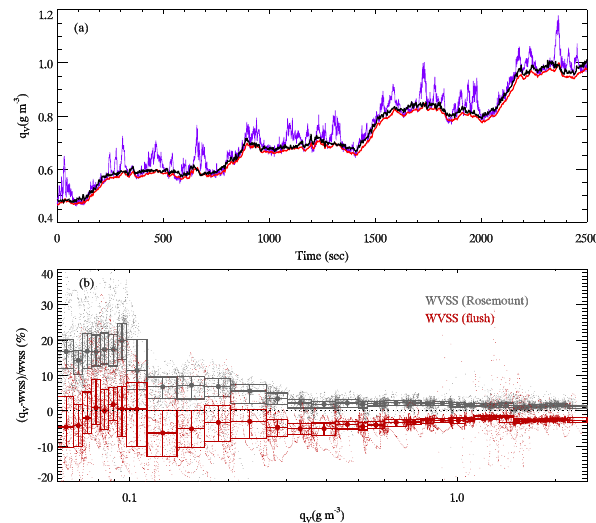
Figure 7. Time series from flight B672 showing part of a La- grangian, “race-track” pattern descent through cirrus cloud with embedded fall streaks. Upper panel shows absolute humidity from wvssF (black), wvssR (red) and TWC (purple). Lower panel shows a comparison of wvssR (red) and wvssF (grey) to the Buck during this flight in terms of absolute humidity with boxes indicating upper and lower